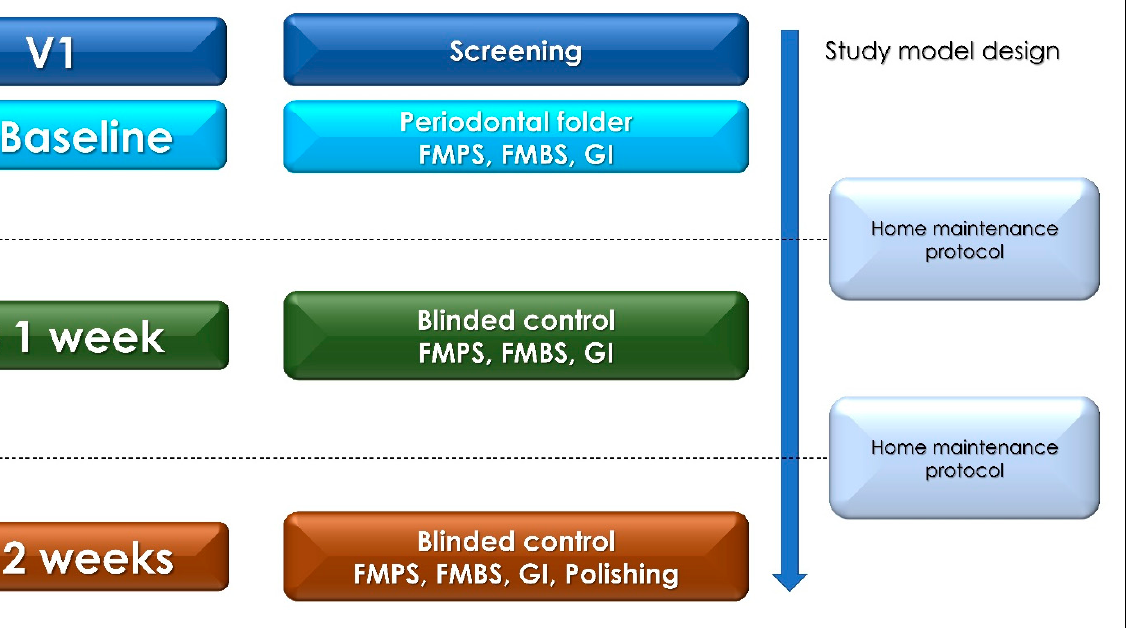
Figure 1. Clinical Trial and study design flowchart (V1, First visit; V2, baseline visit, V3, 1 week visit; and V4, 2 weeks visit).